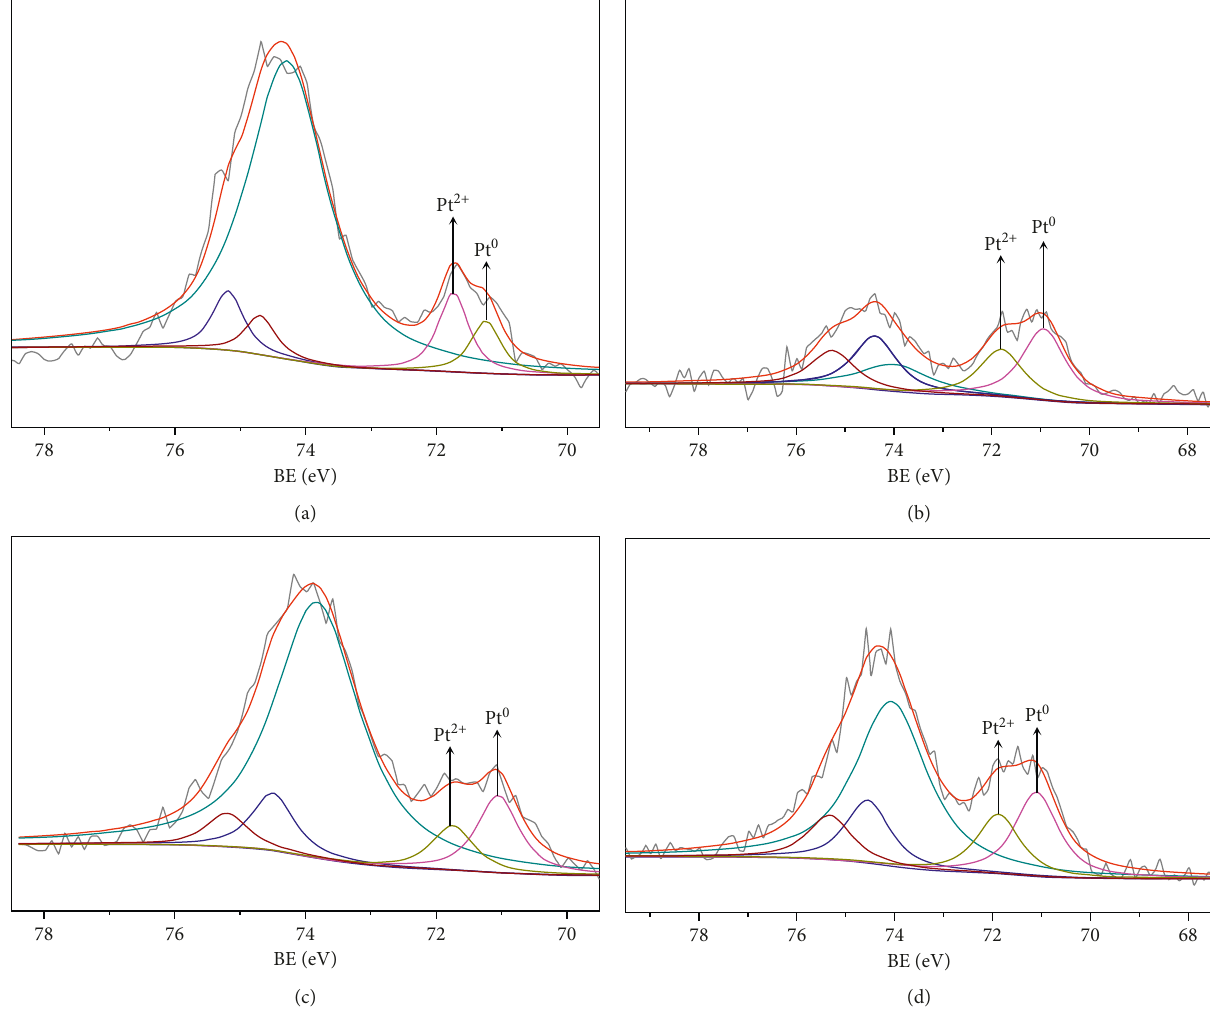
Figure 4: XPS spectra of the as-prepared catalysts: (a) 1% Pt/MORn; (b) 1% Pt/MORn-H; (c) 1% Pt/MORn-OH; (d) 1% Pt/MORn-H-OH. Table 1: XPS results of the series of 1.0% Pt/MORn catalysts.